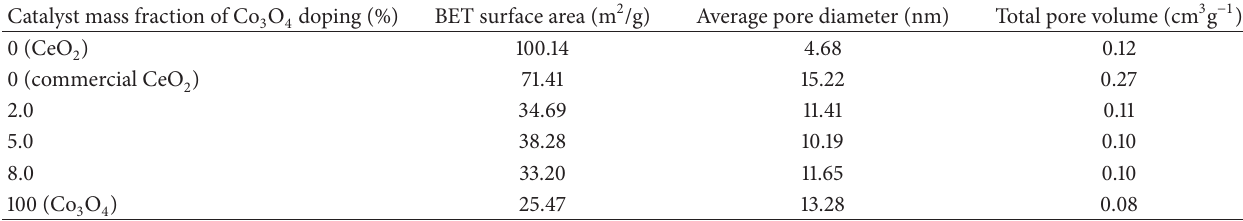
O /CeO catalysts with different mass fraction of Co 3 4 2